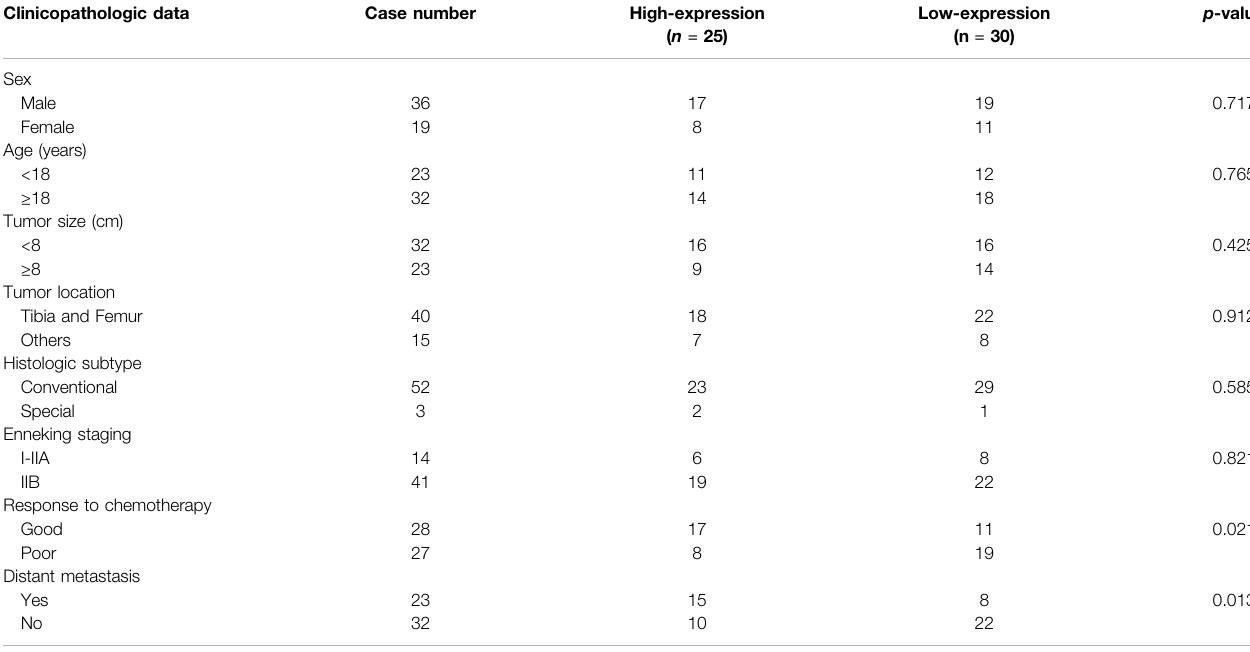
TABLE 1 | Association between NLRP3 expression and clinicopathological characteristics in osteosarcoma. Clinicopathologic data